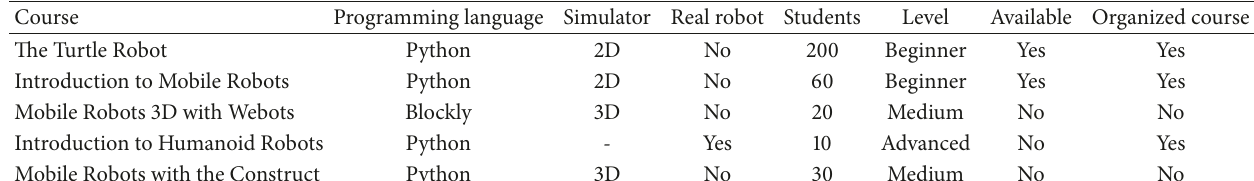
Table 1: General characteristics of the courses. The column ”Students” represents the total number of students inscribed in the course from the start of the course to 2017.